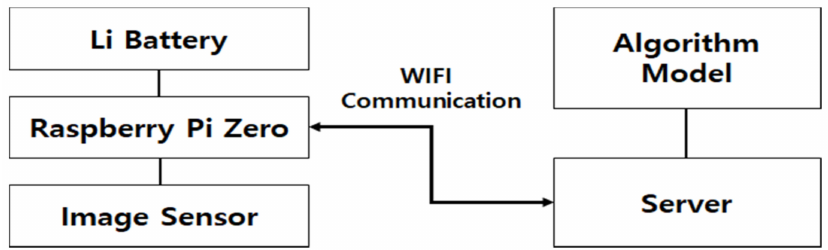
Figure 2. Structural diagram of a smartwatch implemented with Raspberry Pi .